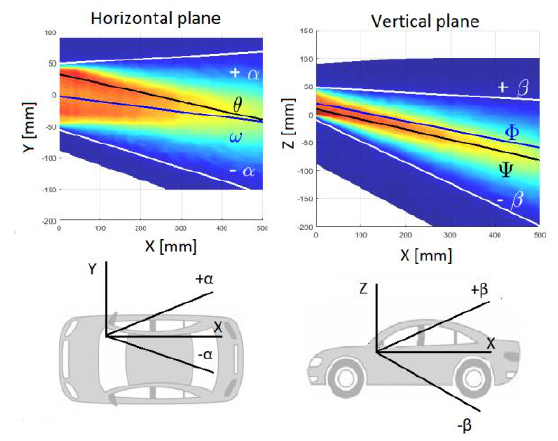
Fig. 6. The coordinate system